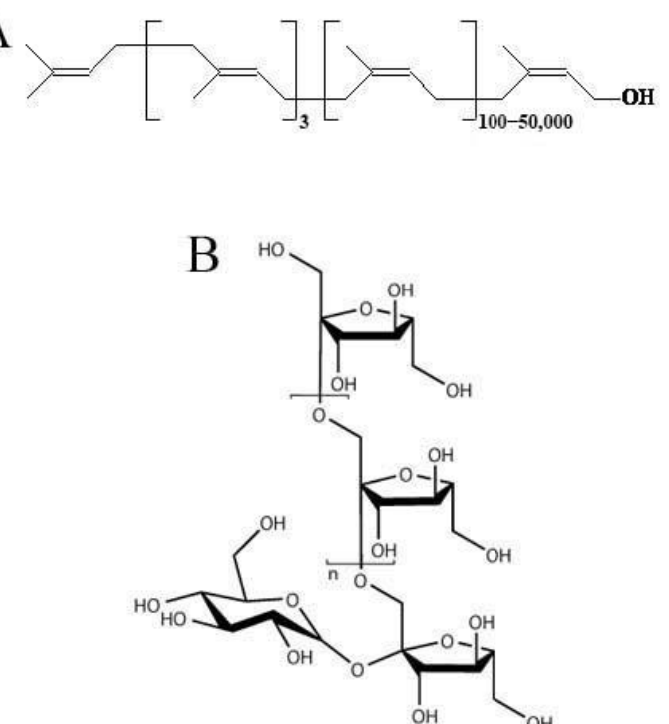
Figure 1. ( A ). Chemical structure of natural rubber. ( B ). Chemical structure of inulin. Natural rubber has superior elasticity, tackiness, strength, thermal properties, elas- ticity, abrasion resistance, and impact resistance compared with synthetic rubber due to its unique molecular structure and high molecular weight (>1 million g/mol) [6]. Aircraft tires always contain a lot of NR. Truck tires are 30–40% NR and even car tires always contain a certain proportion (15–20%) of NR [6]. Natural rubber consists mainly of linear rubber polymers ( cis -1,4-polyisoprene, Figure 1A) and secondary components (non-rub- ber components) that distinguish it from synthetic rubber. Non-rubber components in- clude proteins and resins (fatty acids, triglycerides, sterols, etc.). These elements may